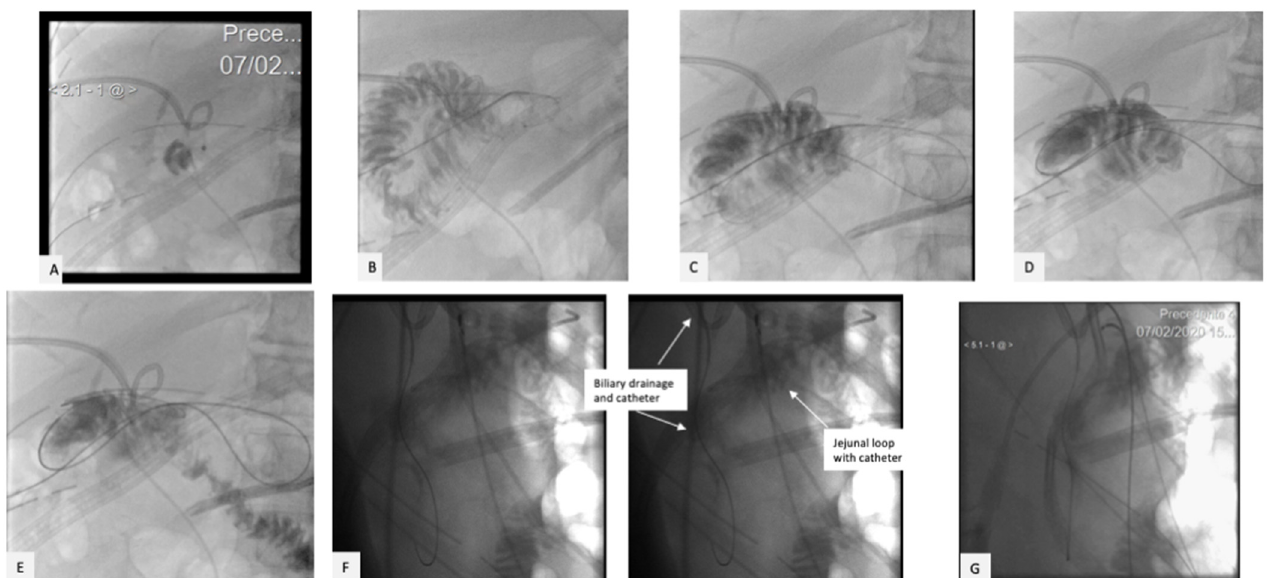
Figure 5. The afferent jejunal loop was then punctured with US and fluoroscopic control ( A ), and the bile collection was reached with a hydrophilic guide and an angiographic catheter ( B – E ) passing through the jejunal dehiscence. Latero-lateral projection ( F ) and CBCT acquisition ( G ) confirmed that the jejunal loop was anterior to the angiographic catheter positioned into the biliary tree. A snare loop catheter (Amplatz GooseNeck Snare Kit) was then advanced through the jejunal loop into the biloma: the transhepatic hydrophilic wire was then captured with the snare and pulled into the jejunal loop (Figure 6).